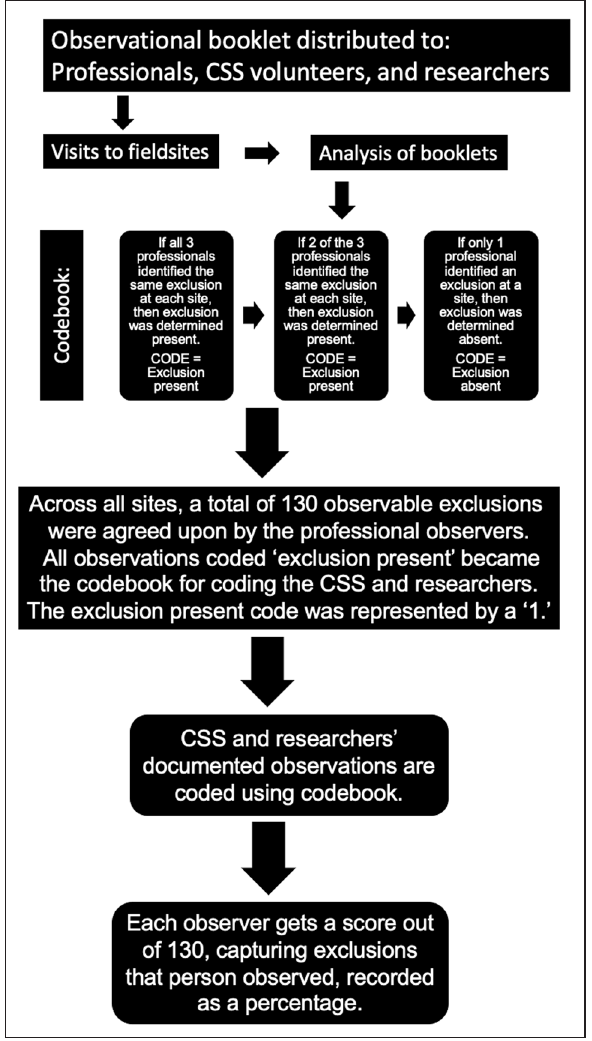
Figure 2 Steps of qualitative analysis of observation